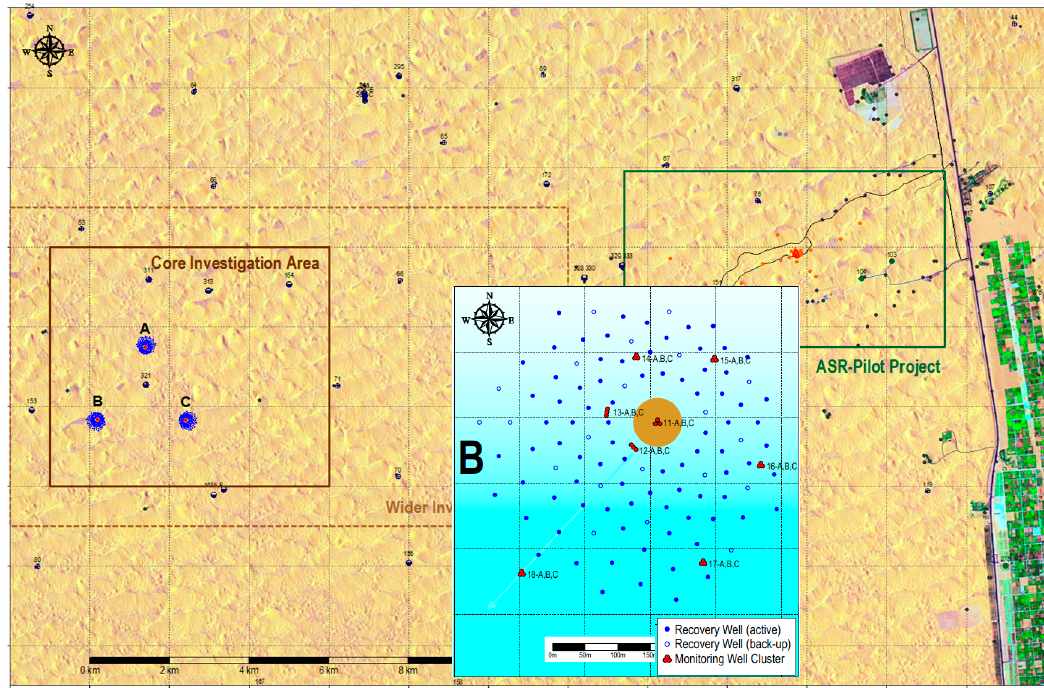
Figure 3. Detailed location map, showing the ASR pilot area and Liwa’s SWSR well field clusters A, B and C, each surrounding a large circular underground recharge basin. Slightly modified from: GTZ-Dornier (with permission) [9].